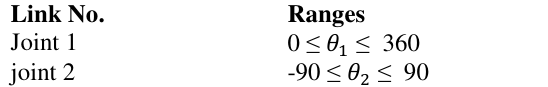
Table 1, The theoretical range of the two-link Robot Arm Link No.